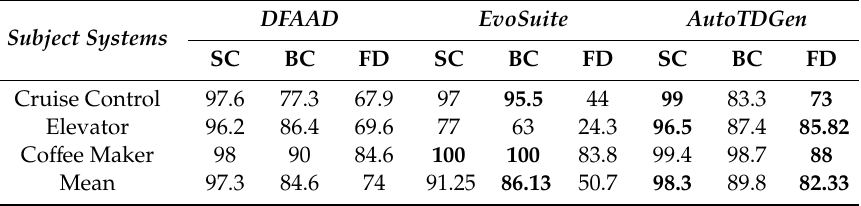
Table 4. The overall statement coverage (SC), branch coverage (BC), and fault detection (FD) ratio achieved across subjects and applied